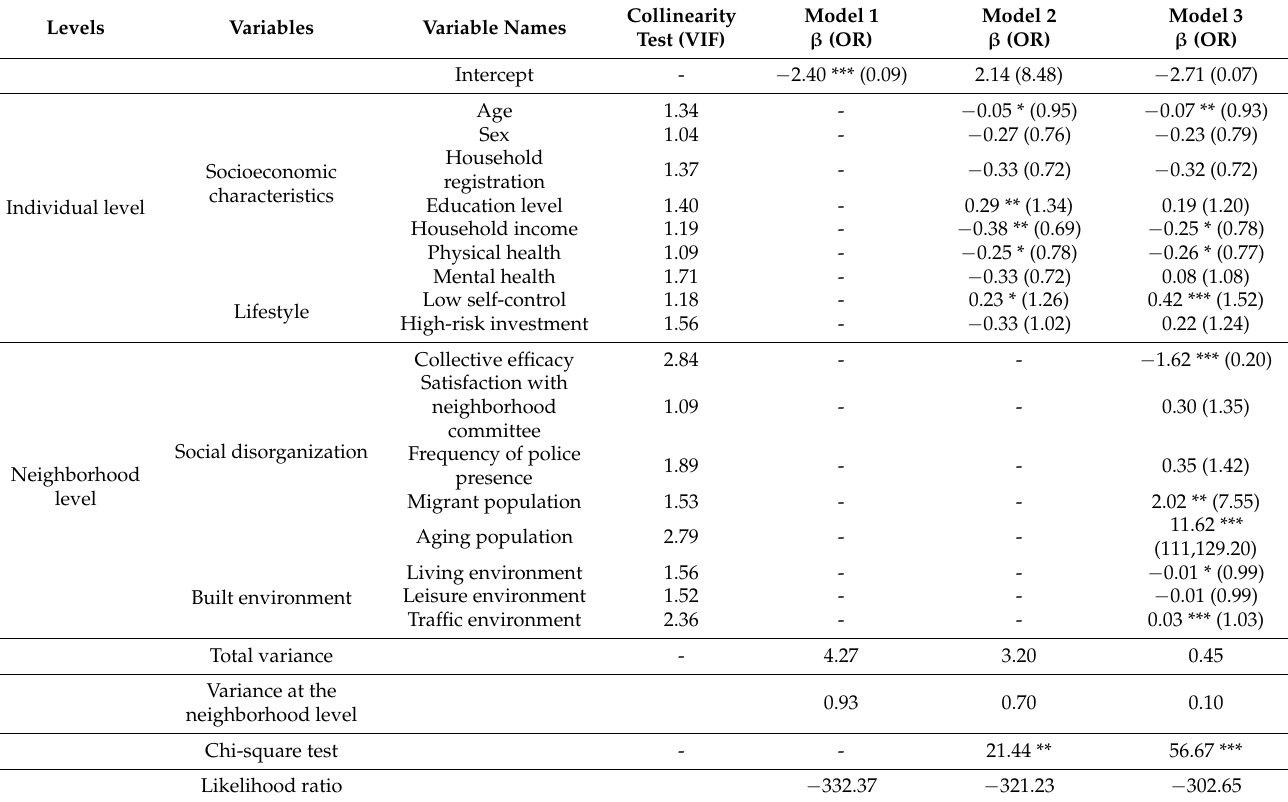
Table 4. Multilevel logistic regression model results of contact-fraud victimization among the